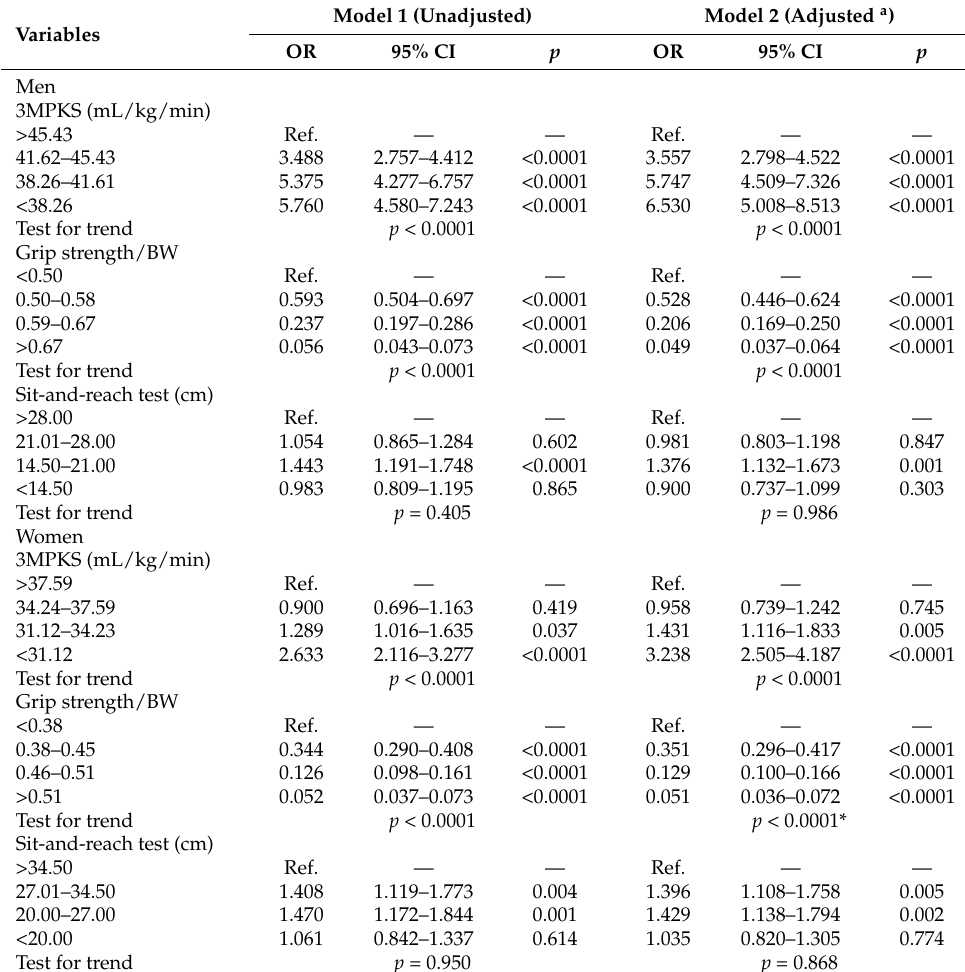
Table 6. Multivariate adjusted ORs for obesity in relation to quartiles of scientific physical fitness measurements after adjustment for potential confounders (n =